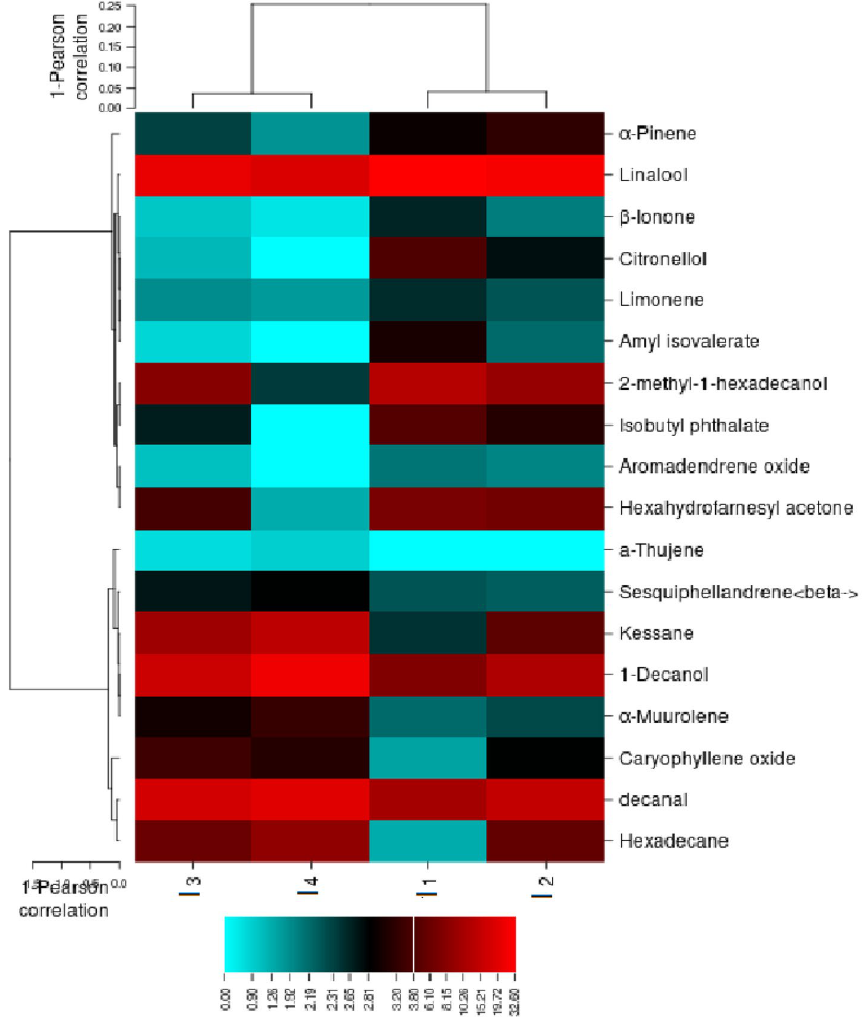
Figure 13. Heatmap for the essential oil profile in aerial parts of Lavandula stricta corresponding to irrigation regimes (CIMminer, https:// disco ver. nci. nih. gov/ cimmi ner/ oneMa trix.